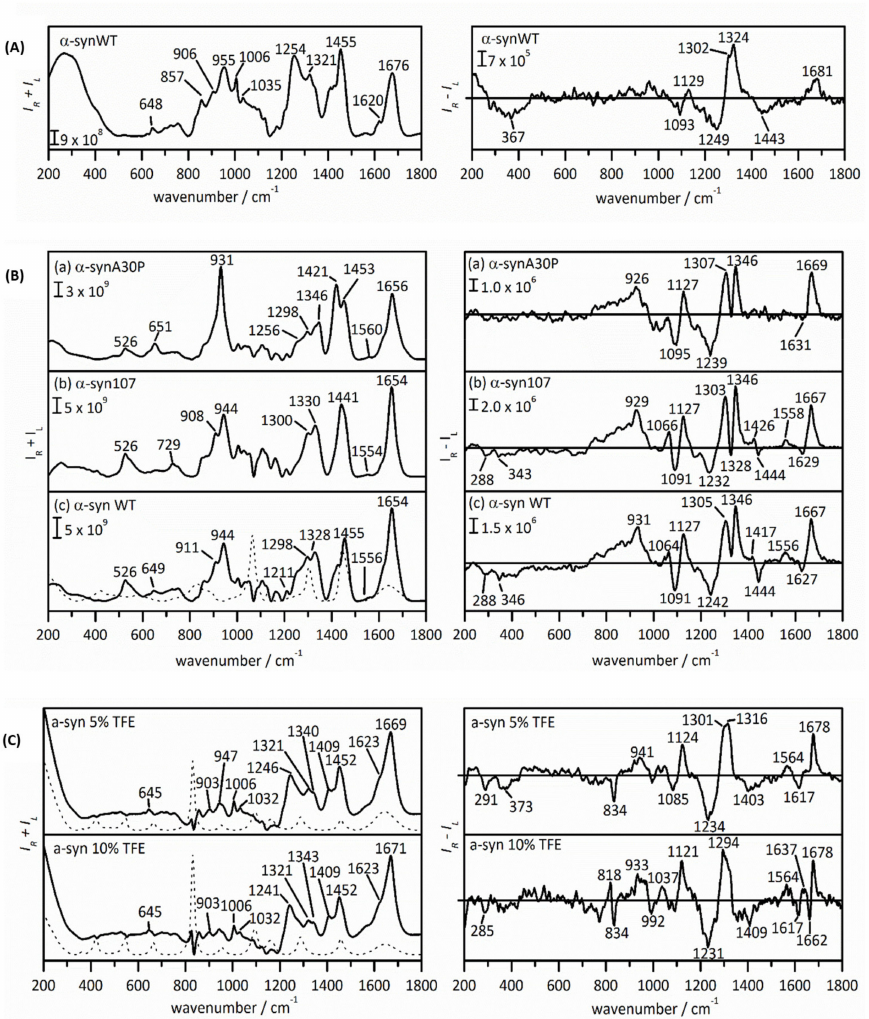
Figure 16. The Raman (left) and ROA (right) spectra of human wild-type α -synuclein in aqueous solution ( A ); the α -synuclein A30P variant ( a ), the α -synuclein 107 variant ( b ) and human wild- type α -synuclein ( c ), all in a high concentration of sodium dodecyl sulphate solution ( B ); wild-type α -synuclein in 5% (top) and 10% v / v (bottom) 2,2,2-trifluoroethanol (TFE) in demineralised water ( C ). The dashed lines in the Raman spectra are the corresponding solvent background spectrum. Reprinted with permission from ref. [104]. Copyright 2017 John Wiley and